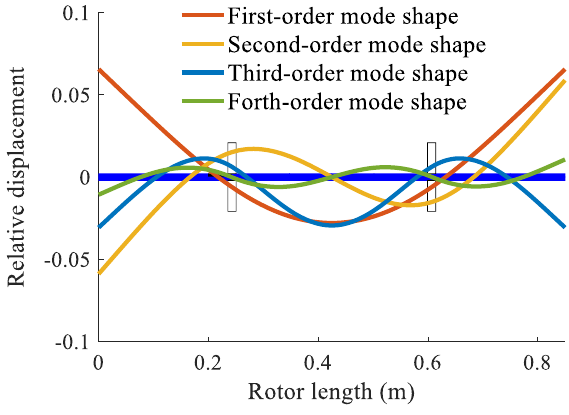
Figure 3. Theoretical mode shapes of the shaft with discs. Table 2. Measured and theoretical (initial, updated) modal frequencies.